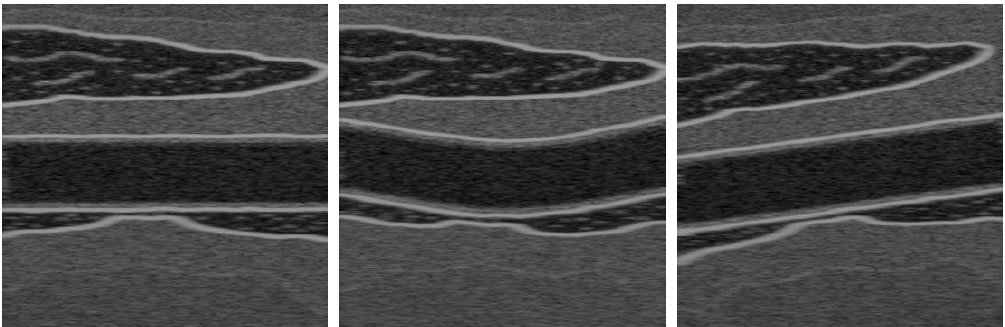
Figure 1. Ultrasound images used in the data set test, generated by Field II U.S.